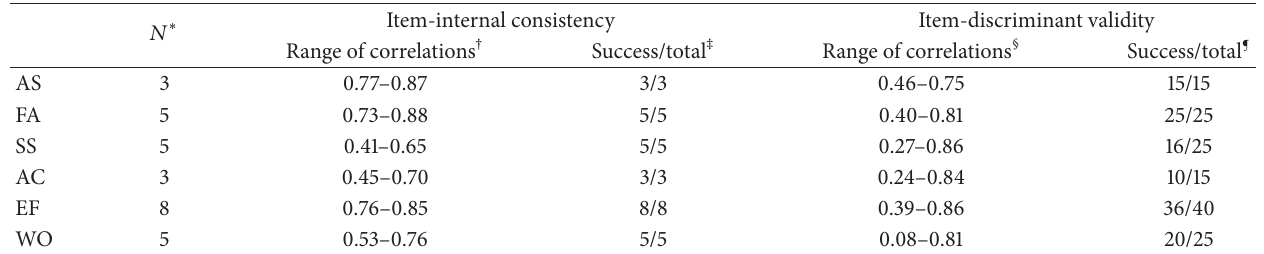
Table 3: Summary results of scaling assumptions tests.